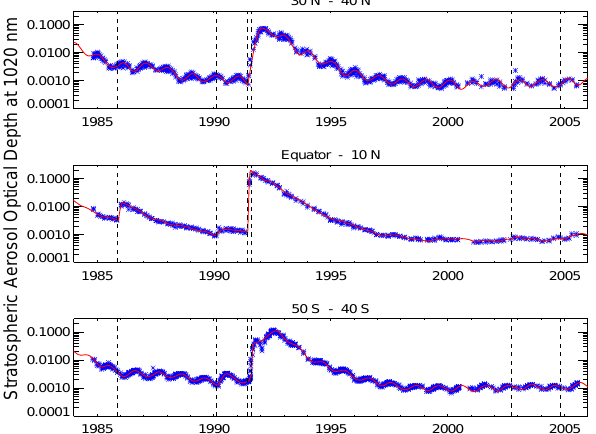
Figure A1. Some examples of the nonlinear fit to aerosol at three different center latitudes (35 ◦ N, 5 ◦ N, and 45 ◦ S). Data within each band are shown in blue, while fits are shown in red. The vertical lines denote the times of the seven eruptions used for the fit (El Chichón is off scale). Note the difference in rates of rise and peak times at different latitudes, most easily visible for